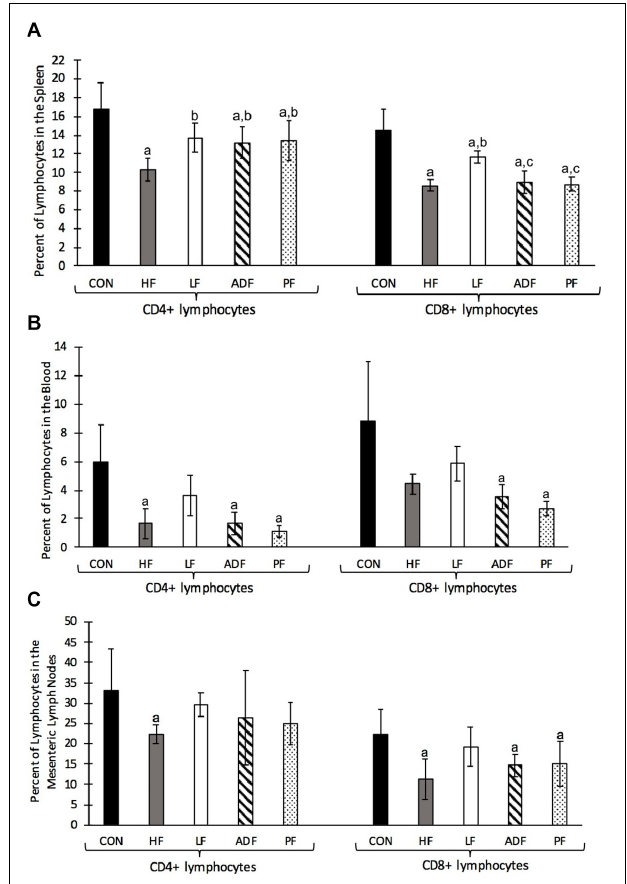
FIGURE 6 | Single cell suspensions from the spleen, blood, and mesenteric lymph nodes were stained with anti-CD3, anti-CD4, and anti-CD8 monoclonal antibodies and analyzed by flow cytometry. The lymphocyte population was gated based on FSC vs SSC profiles then CD3 + cells gated and used as the parent population for CD4 + and CD8 + T cell identification. Graphs show mean and SD of the percentage of CD4 + and CD8 + T cells of lymphocytes. (A) Frequency of T cells in the spleen. All diet regimens had a lower percentage of splenic CD4 + and CD8 + T cells compared to the CON group. The LF group had a significantly higher percentage of CD4 + and CD8 + T cells compared to the HF group. (B) Frequency of T cells in the blood. HF, ADF, and PF groups had reduced frequencies of CD4 + and CD8 + T cells in the blood, while the LF group showed no significant reduction. (C) Frequency of T cells in the mesenteric lymph node. HF, ADF, and PF groups had reduced frequencies of T cells in the mesenteric lymph nodes while the LF group showed no significant reductions in T cell frequency. a: p < 0.05 vs. CON; b: p < 0.05 vs. HF; c: p < 0.05 vs. LF for each respective lymphocyte